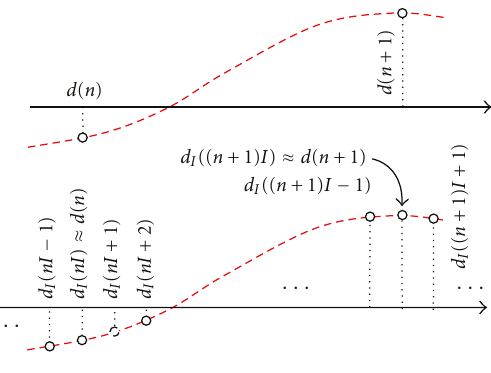
Figure 4: Upsampling d ( n ) to get d I ( n (cid:2) )